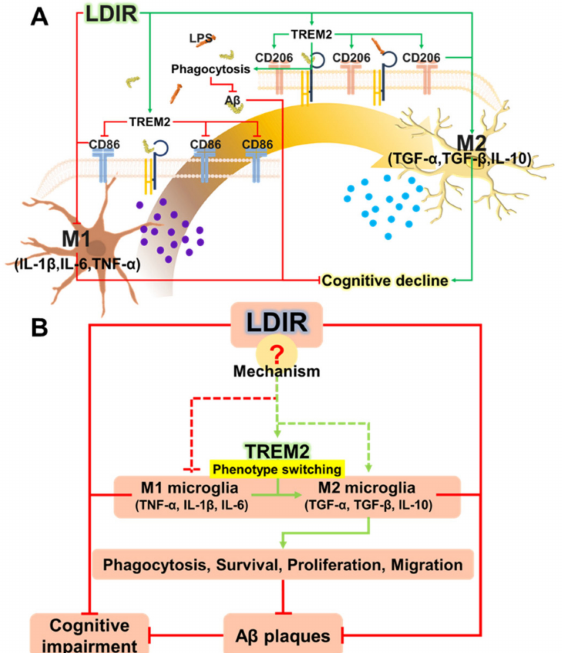
Figure 6. ( A ) Schematic drawing of the modulatory e ff ects of LDIR exposure on shifting microglial phenotypes. ( B ) Proposed mechanisms for how LDIR treatment is able to reduce A β accumulation and cognitive